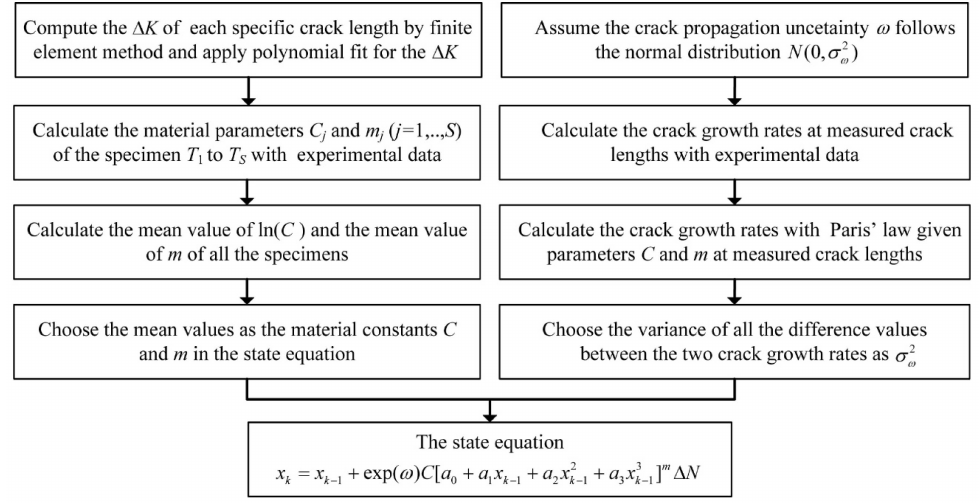
Figure 1. The process to obtain the state equation